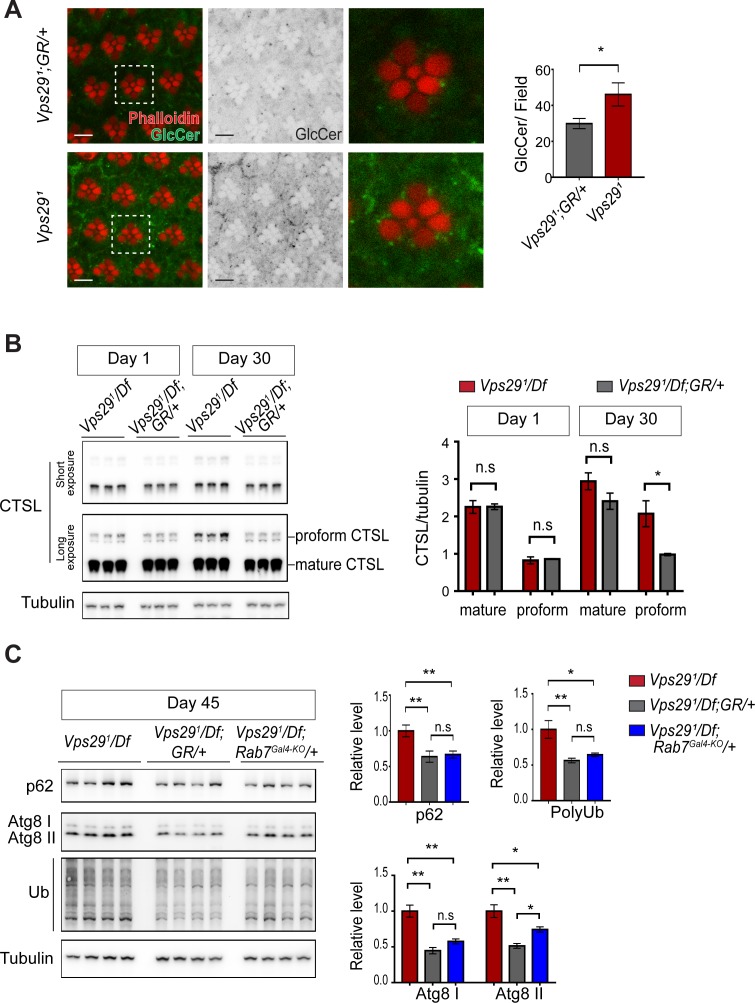
Loss of Vps29 causes age-dependent, progressive lysosomal dysfunction in the brain.(A) In the absence of Vps29, glucosylceramide (anti-GlcCer, green) accumulates in the retina. Tissue is counterstained for actin (phalloidin, red) to highlight the photoreceptor rhabdomeres. Glucosylceramide signal was quantified from a 36.94 × 36.94 µm2 region encompassing ~10 ommatidia in 30-day-old animals (n = 10) raised in dark conditions, including GMR-w-RNAi/+; Vps291; GR/+ (controls) and GMR-w-RNAi/+; Vps291. Eye pigment was removed using RNAi against the w gene to reduce auto-fluorescence. A representative ommatidium (boxed) is shown at higher-power (right). Scale bars, 5 µm. (B) The uncleaved, CTSL proform is increased in aged animals lacking Vps29, consistent with diminished lysosomal proteolytic capacity. Western blots from adult fly head homogenates were probed for CTSL and Tubulin (loading control), and quantified based on n = 3 replicate experiments. See also Figure 6—figure supplement 1A. (C) Autophagic flux is reduced in aged animals lacking Vps29, and this phenotype is suppressed by reduction of Rab7. Western blots of adult head homogenates were probed for autophagic markers, including p62, Atg8, polyubiquitin (FK1), or Tubulin (loading control), and quantified based on n = 8 replicate experiments. See also Figure 6—figure supplement 1B,C. Statistical analysis based on Student’s t-test (A, B) and one-way ANOVA (C). All error bars denote SEM. n.s., not significant; *, p<0.05; **, p<0.01.